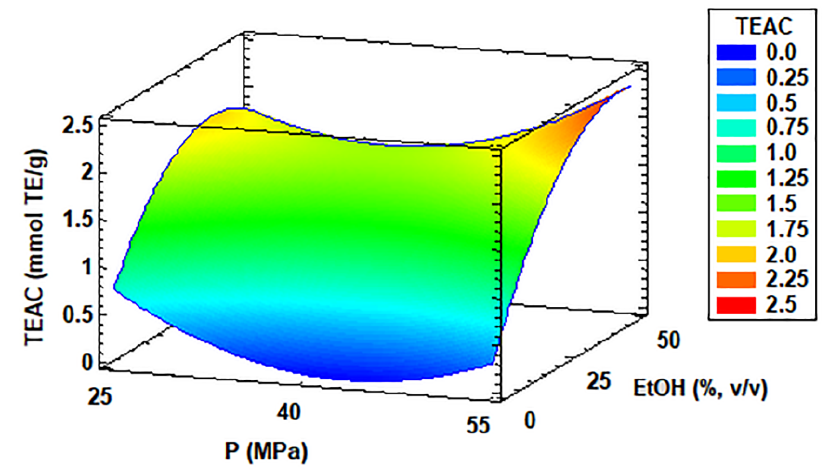
Figure 7. Response surface curve of the combined effects of temperature (30–70 °C), pressure (25–55 MPa), and ethanol as co-solvent (0–50% v / v ) on antioxidant capacity (TEAC) from Coccomyxa onubensis. Response surface curves were drawn from the viewpoint of the optimal temperature (70 °C). Abbreviation: temperature (T), pressure (P), and ethanol as co-solvent (EtOH).